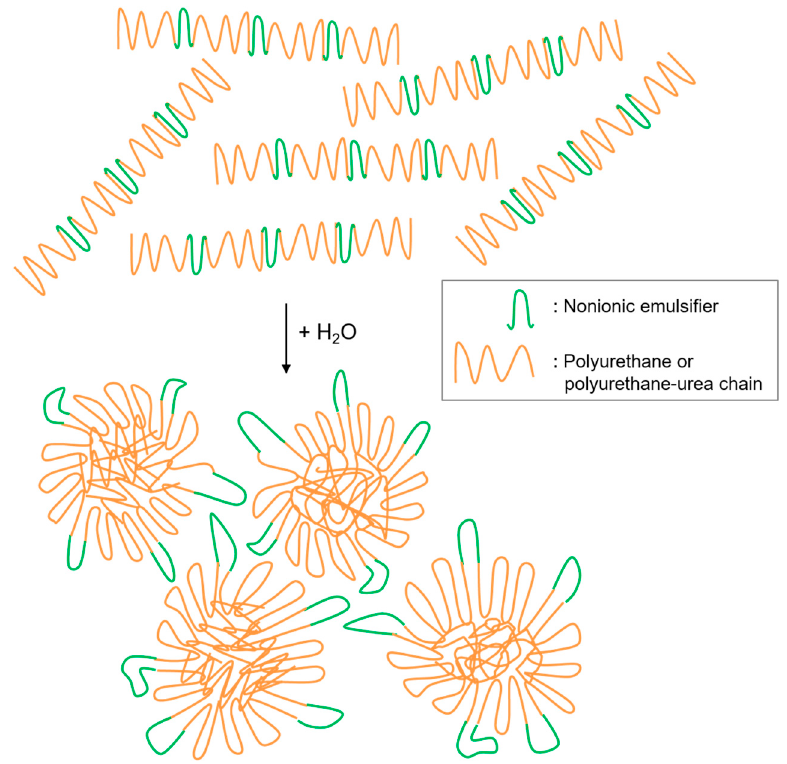
Figure 2. Scheme of particle’s formation in nonionic WBPU or WBPUU dispersions.